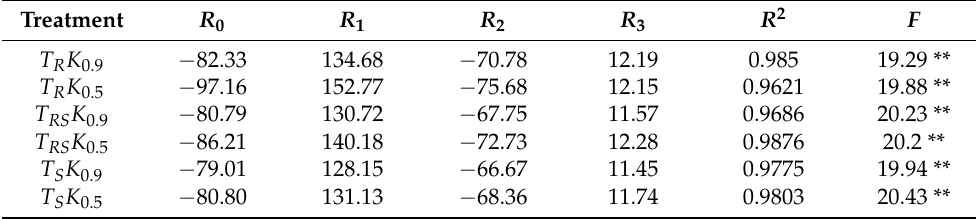
variables and parameter R 0 as the dependent variable over the whole growth stages, the binary quadratic polynomial function could be fitted by using the Levenberg–Marquardt method combined with the general global optimization algorithm by using 1stOpt software ( R 2 of 0.86), which could be derived under different irrigation amounts and air speeds in the equation for parameter R 0